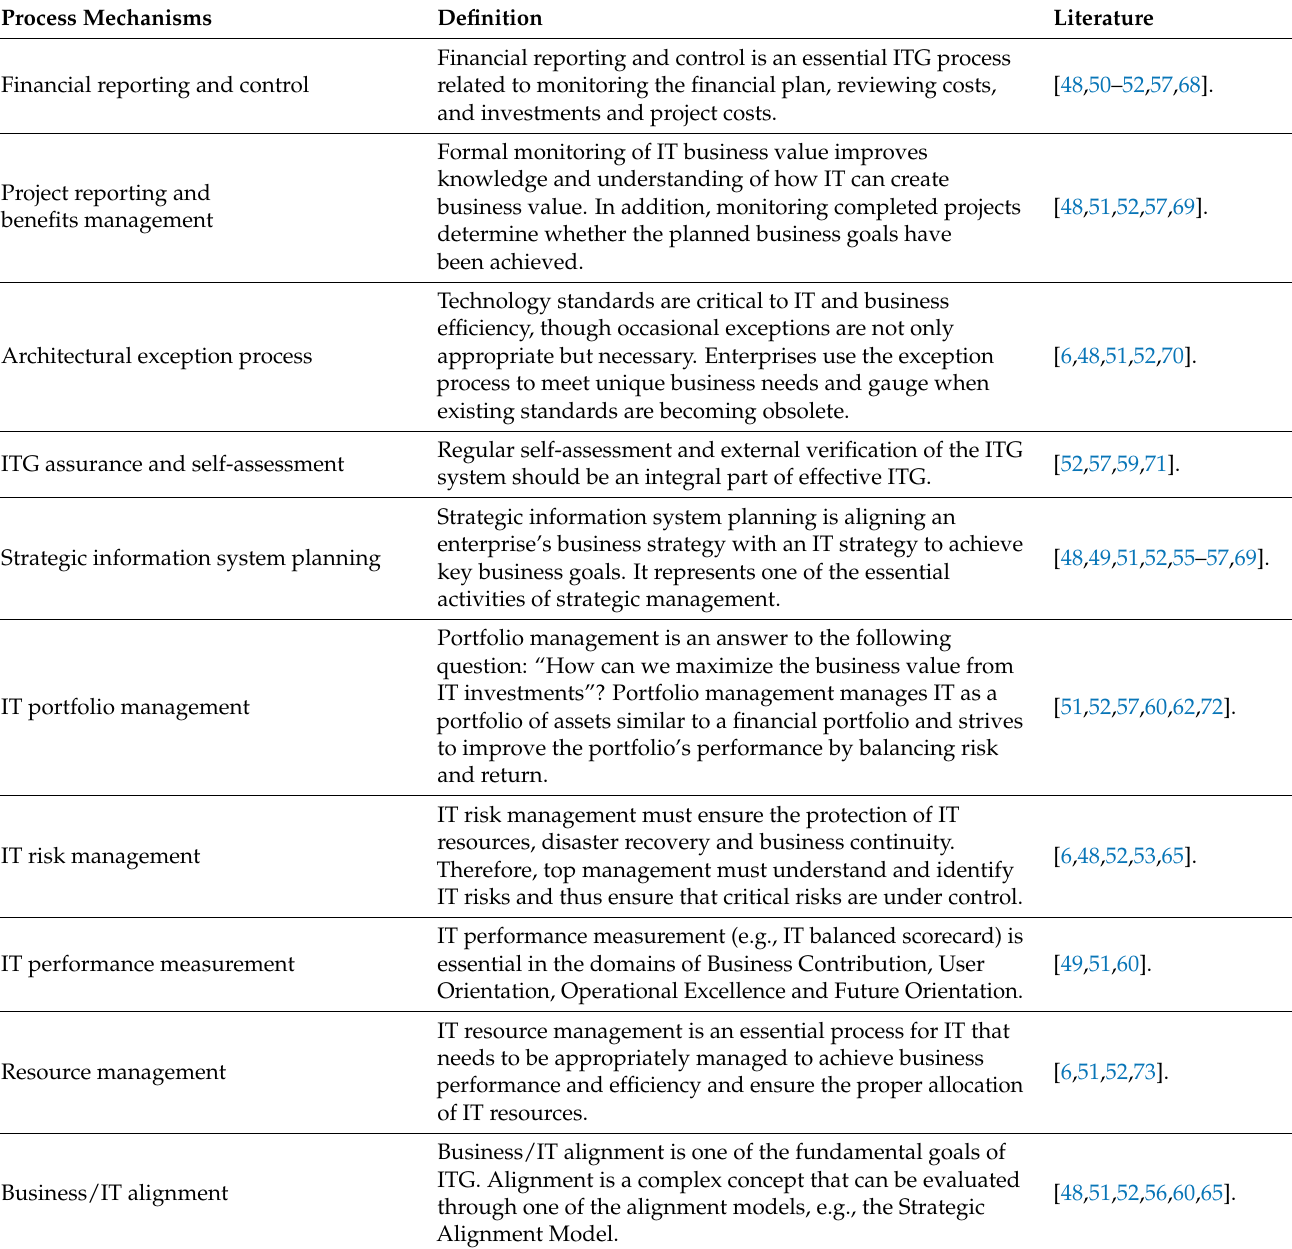
Table 2. Strategic ITG process